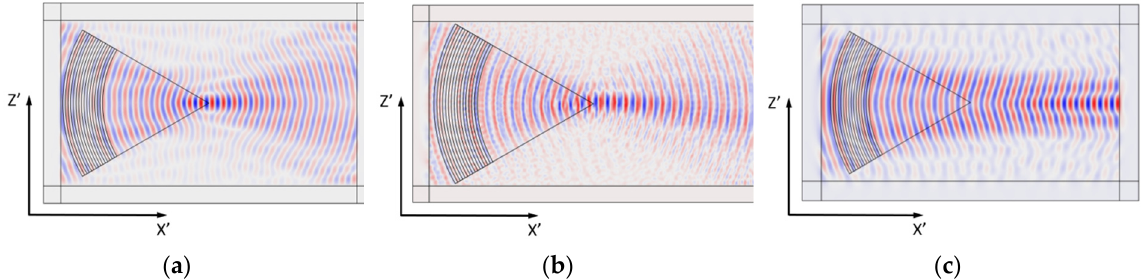
Figure 3. Distribution of the mechanical displacement component U Z’ in the direction of wave propagation X’ for: ( a ) A 0 (128YX, f = 1.849 MHz), ( b ) S 0 (Y − X + 50 ◦ , f = 4.889 MHz), and ( c ) SH 0 (YX, f = 3.7 MHz) waves in a lithium niobate plate ( h = 0.305 mm), excited by electrodes with a constant radius with the angle ϕ .